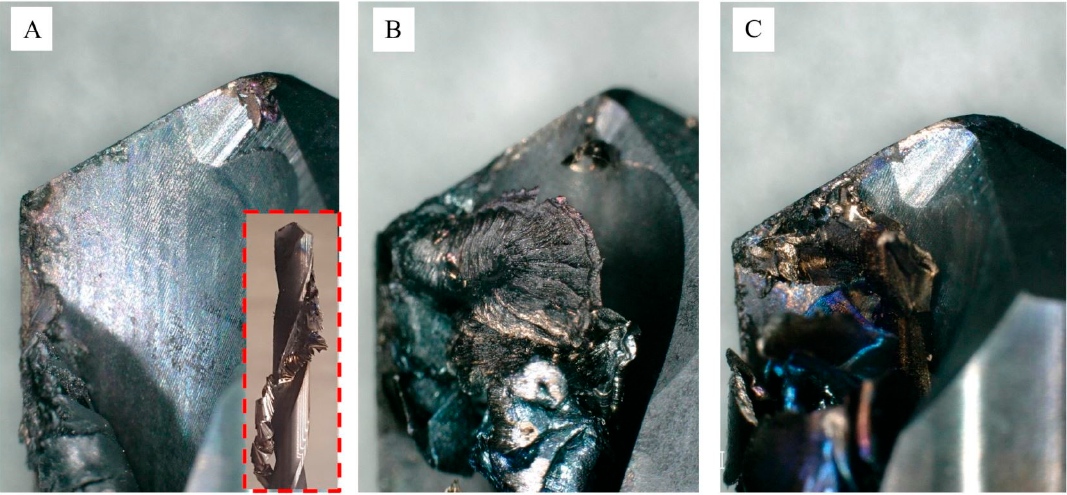
Figure 4. The effect of VAD amplitude on the tool-chip welding process at N = 56.52 m/min and f = 0.075 mm/rev for ( A ) conventional, ( B ) A m = 0.1mm, and ( C ) A m = 0.25mm.